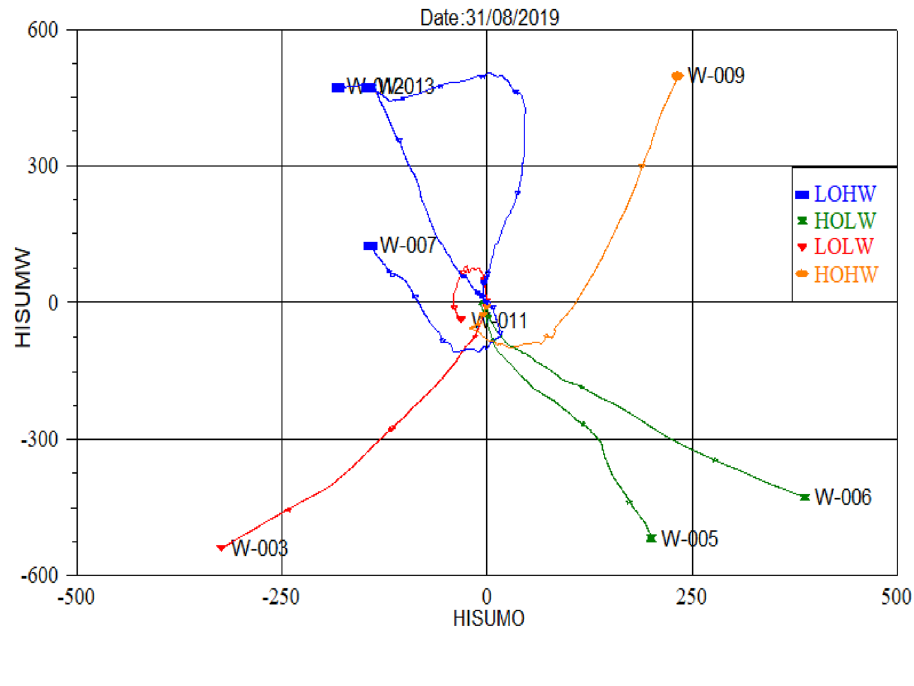
Fig. 5 a kh versus Q map across the reservoir